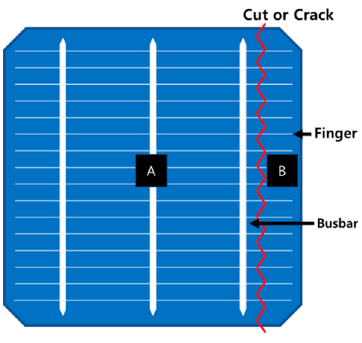
Figure 1. Vertical cut of a c-Si solar cell.